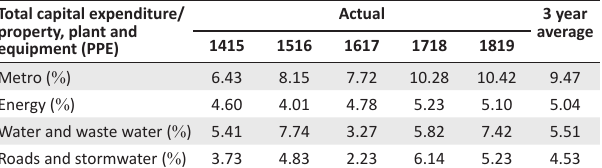
TABLE 3: Averages of capital acquisition over total property, plant and